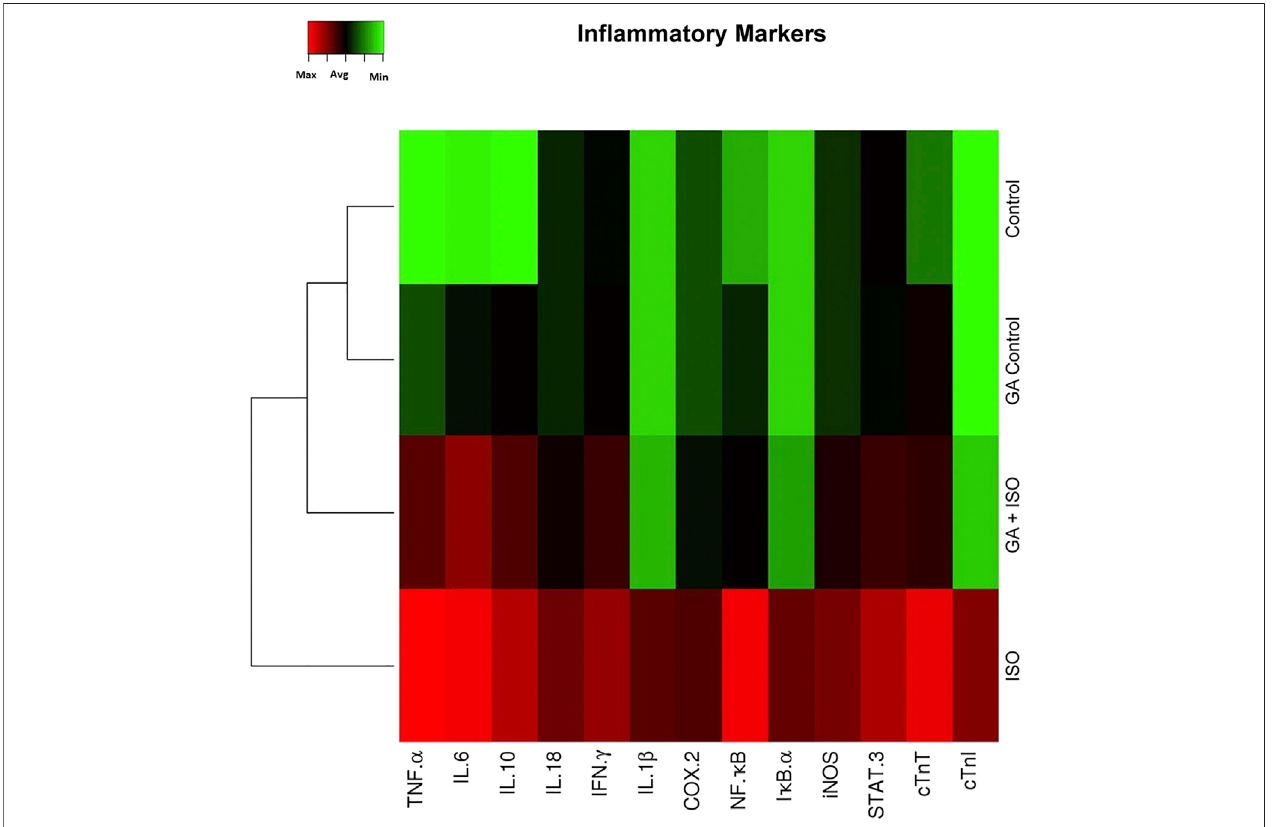
FIGURE 3 | Effect of GA on ISO-induced in fl ammatory gene expression in heart tissue. Hierarchical clustergram analysis of PCR array results of GA and ISO- induced rats. Bright red indicates the highest normalized signal values, bright green represents the lowest signal values and black represents median signal values. The total mRNA was isolated from heart tissues and were detected using custom PCR array following the manufacturer ’ s instructions. The clustergram results of three independent experiments were analyzed using the SA Biosciences online tool. Tumour necrosis factor- α (TNF- α ), Interleukin-6, -10, -18, -1 β (IL-6 IL-10, IL-18, IL- 1 β ), Interferon- γ (IFN- γ ), Cyclooxygenase-2 (COX-2), Nuclear Factor kappa-light-chain-enhancer of activated B (NF- κ B), Inhibitor of I κ B- α (I κ B- α ), Inducible nitric oxide synthase (iNOS), Signal transducer and activator of transcription-3 (STAT-3), cardiac troponin T and I (cTnT and